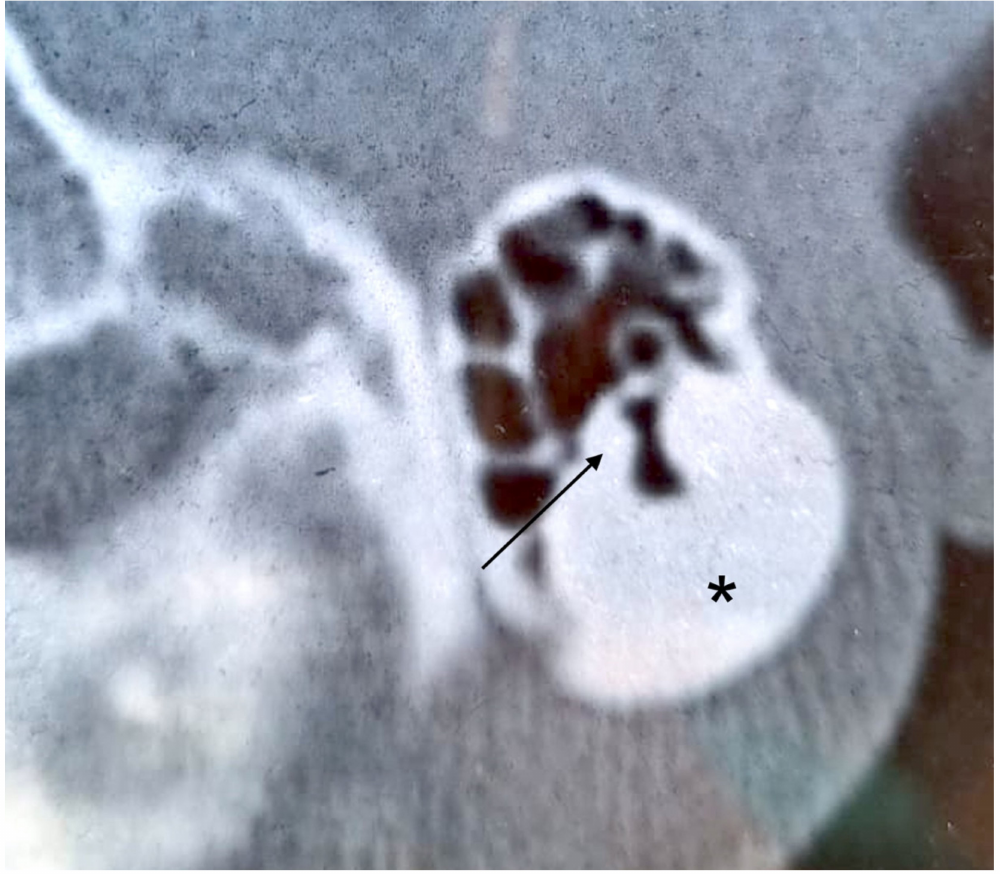
Figure 2. Axial CT scan. Left mastoid cortex osteoma (asterisk) with trabeculae in the deepest component